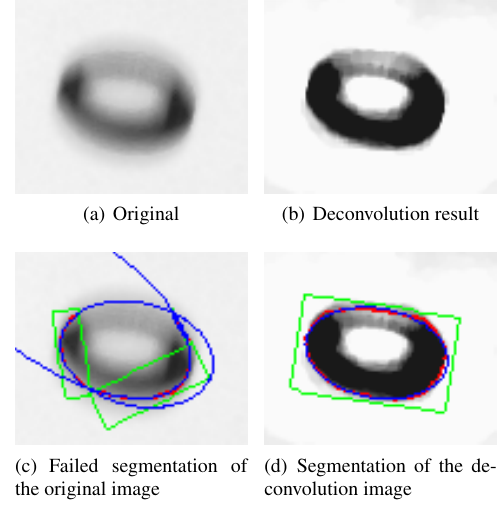
Figure 8: Snake based measurement of a bubble from Figure 7, colors as in Figure